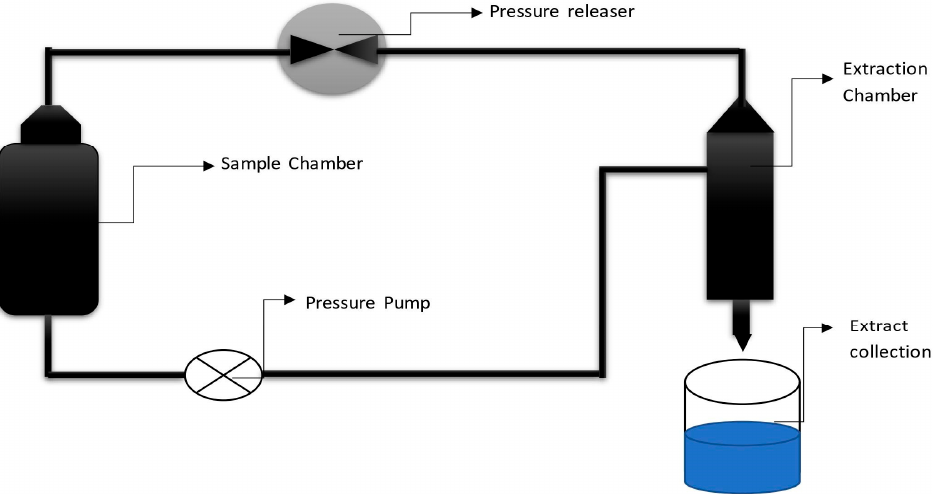
Figure 11. A diagrammatic representation of supercritical fluid extraction.